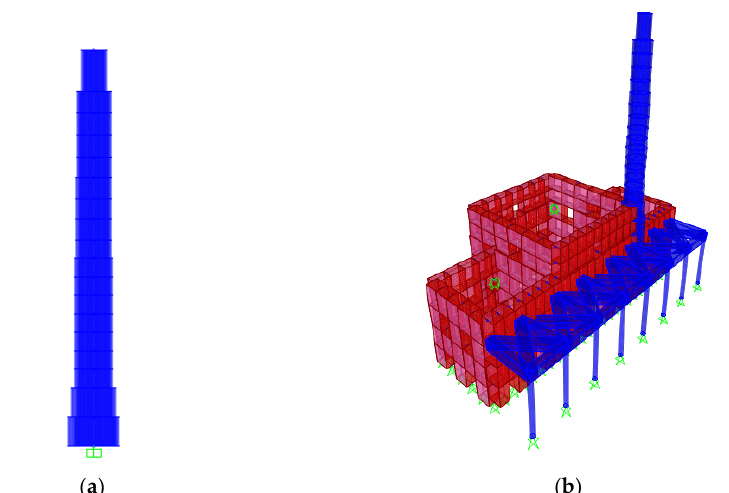
(Figure 9b) simulates the whole mosque. The structure is modeled from the level of 0.00 m up to 21.25 m (Figure 4).